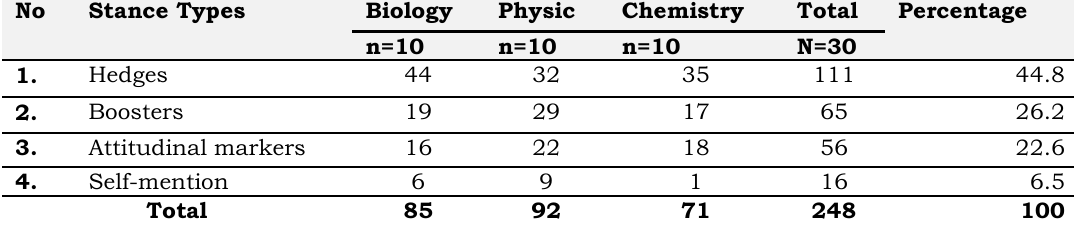
Table 3. Stance Types in RA Introductions in